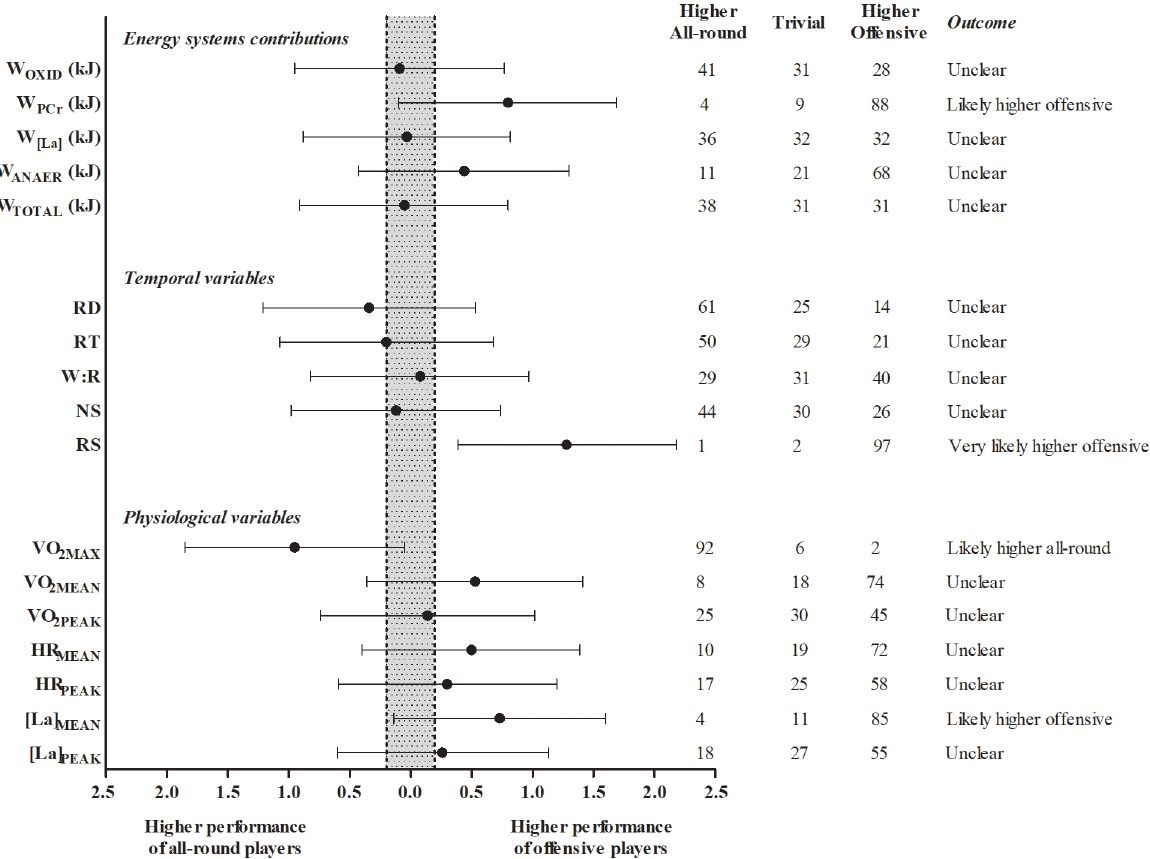
Fig 1. Magnitude-based outcomes for energy systems contributions, temporal variables and physiological variables of all-round and offensive playing